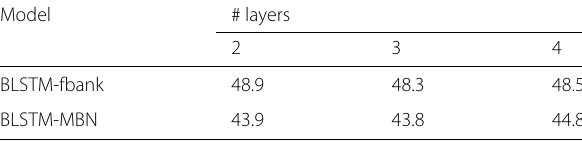
Table 6 WER results vs. the length of the local window